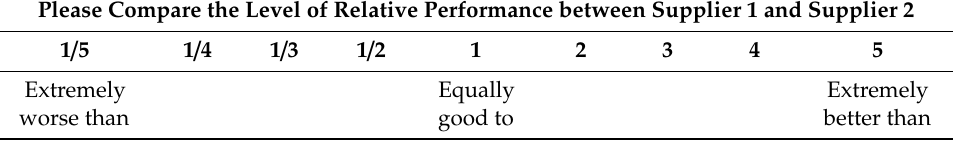
Table 2. The rank scales of pairwise comparison for supplier